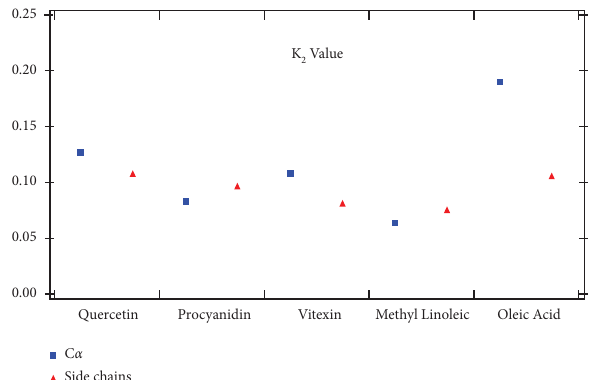
Figure 5: K 2 coefcient value of ftted RMSD.